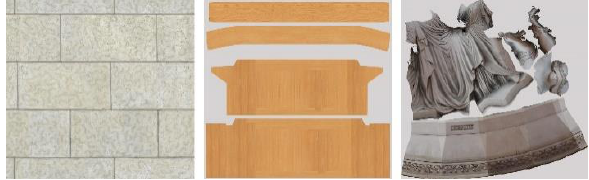
Figure 8. Three different types of textures used in materials: 1) tiling 2) render-to-texture and 3) photogrammetric.